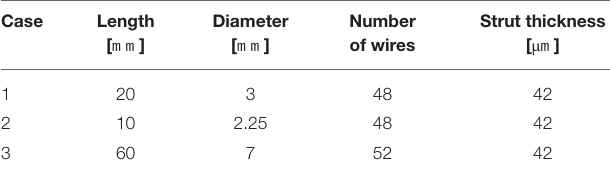
TABLE 1 | Nominal geometric parameters of the virtual flow-diverter stents for each patient-specific FIA.